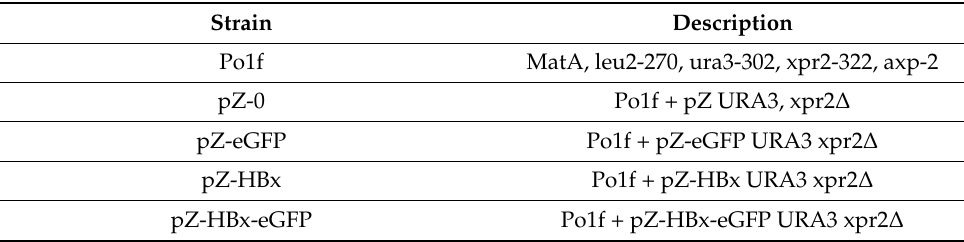
Table 1. List of strains.